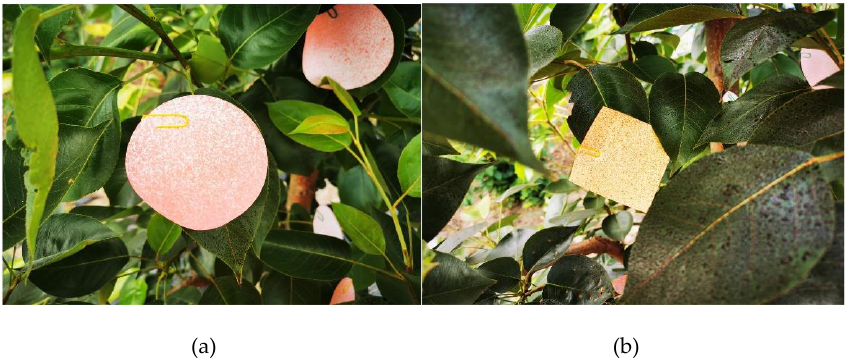
Figure 7. Detection of spray droplet coverage and deposition in the inner canopy. ( a ) Filter paper to detect droplet. ( b ) Cardboard to detect coverage.